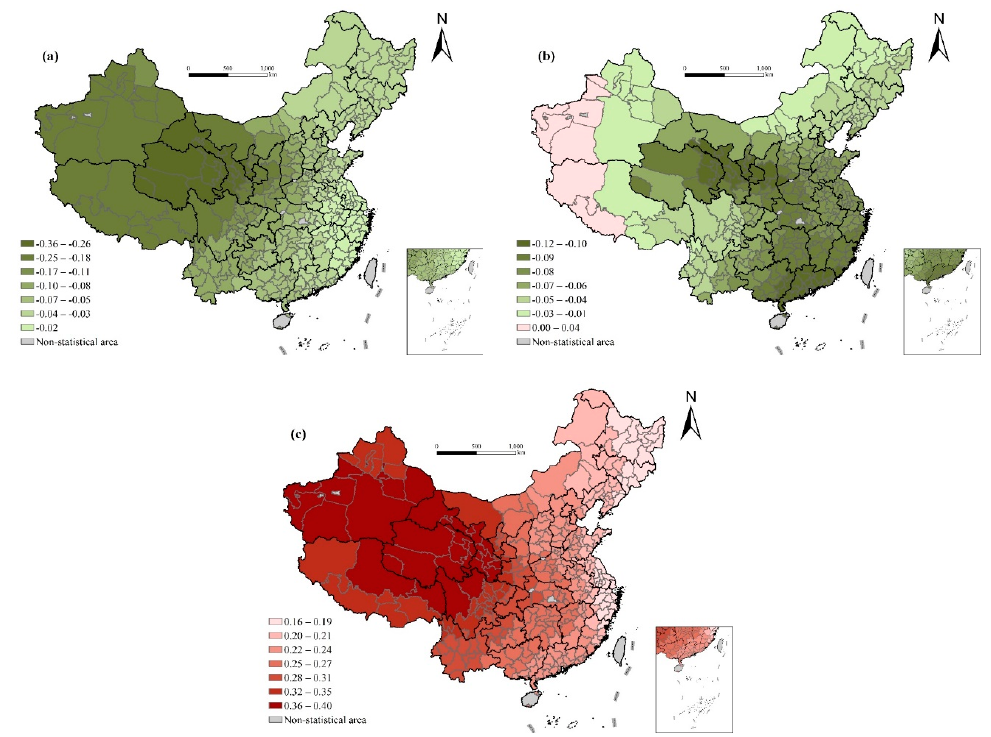
Figure 7. Spatial variation of regression outputs from the GWR model: ( a ) average annual PM2.5 concentration; ( b ) average altitude (ln); and ( c ) perennial mean